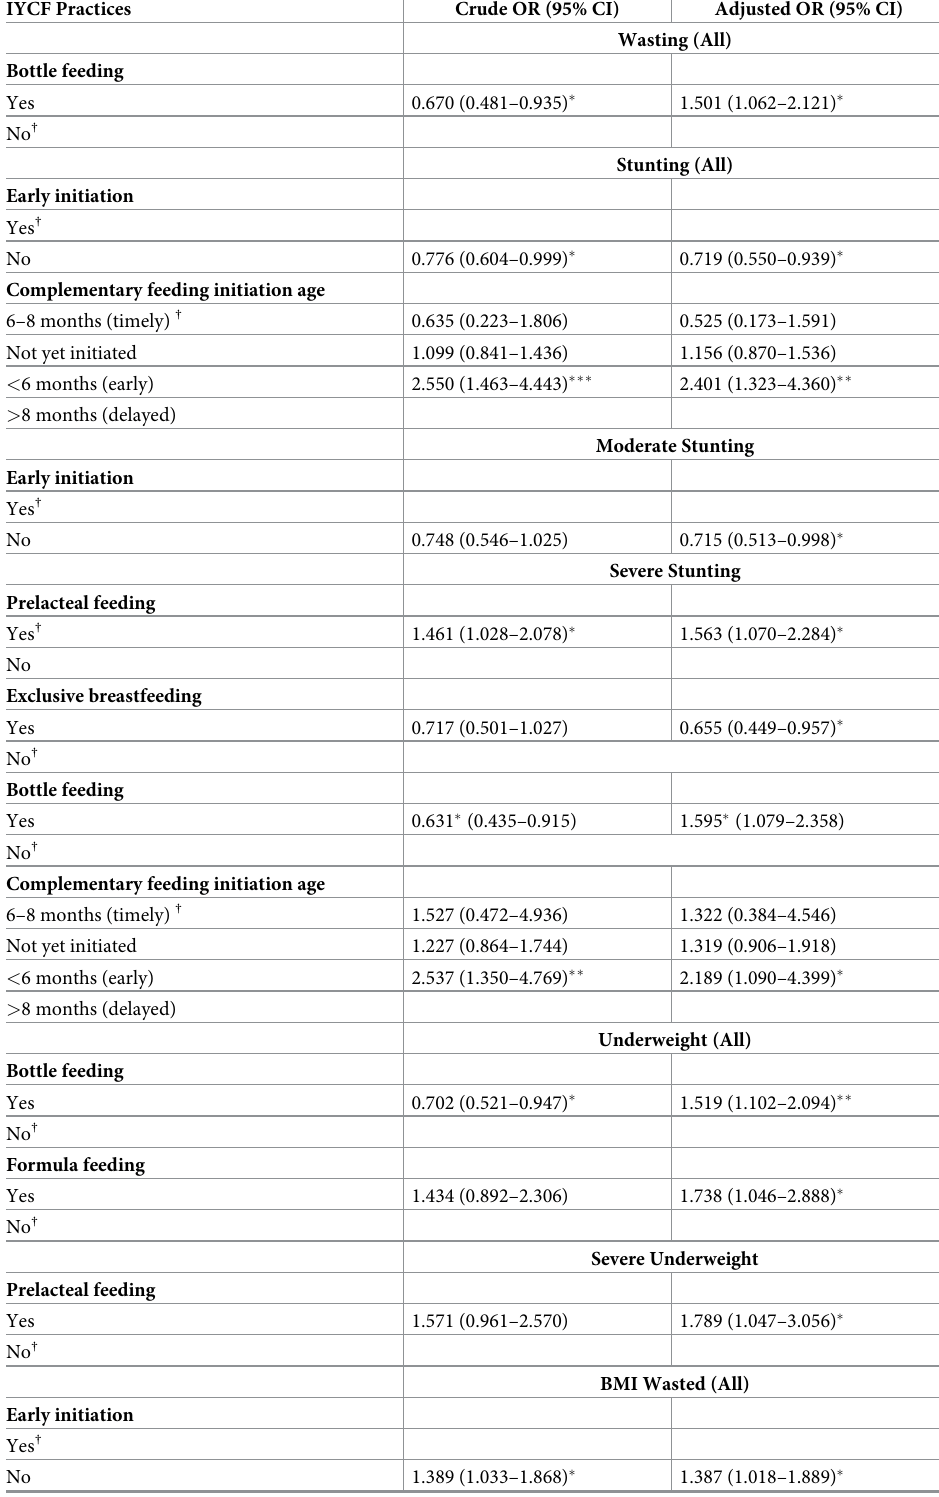
Table 5. Crude and adjusted odds ratio of IYCF practices significantly associated with nutritional